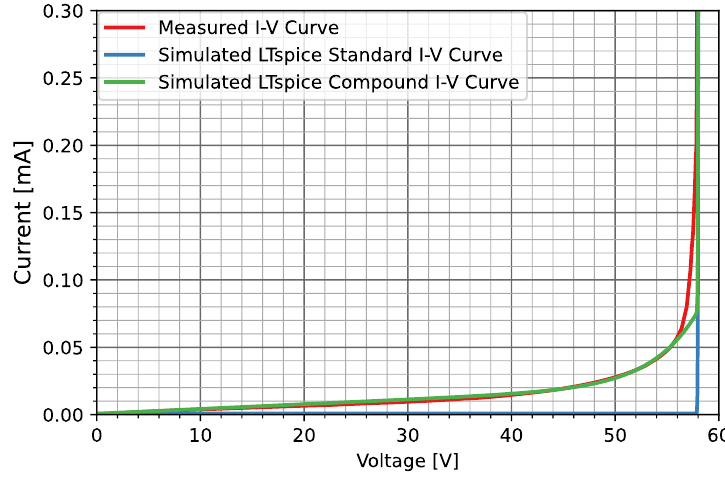
Figure 24. Measured and simulated reverse bias plots for the VSB2045